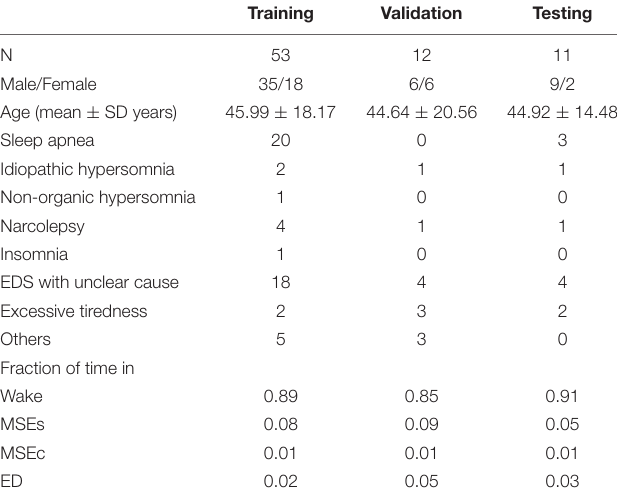
TABLE 1 | Demographics, diagnosis and fraction of time spent in the four stages of patients contributing to the training, validation, and test set: total number of patients (N), number of males/females, mean age and standard deviation, number of patients with a suspected diagnosis of sleep apnea, idiopathic hypersomnia, non-organic hypersomnia, narcolepsy, insomnia, EDS with unclear cause, excessive tiredness, and others, and the fraction of time spent in wake, MSEs, MSEc, and